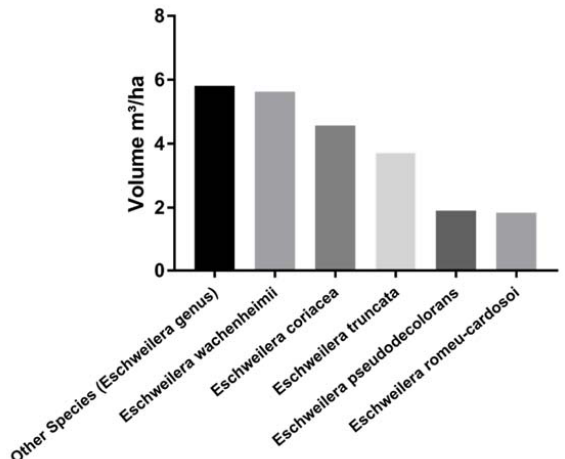
Figure 5. Volume per hectare of Eschweilera genus in which five species (of 20 species identified by the forest inventory in the N-S/E-W transects) represent almost 75% of the total volume of the genus.